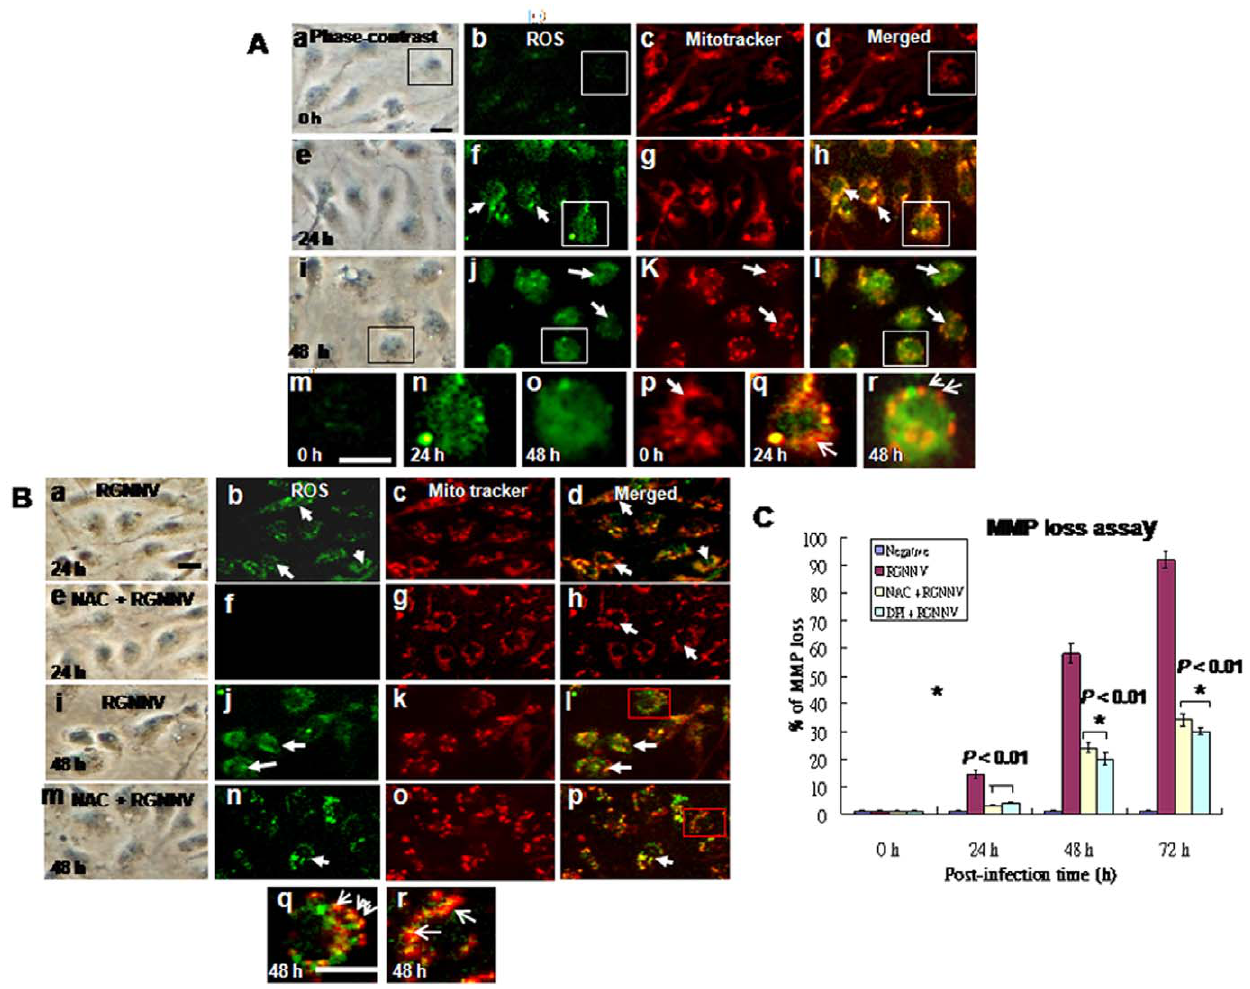
Figure 6. Identification of RGNNV-induced ROS production and the effect of ROS on mitochondrial morphology and loss of DY in GF-1 cells. Phase-contrast and fluorescence micrographs showing ROS production (the Image-iT LIVE Green Reactive Oxygen Species Detection Kit) and mitochondrial morphology (stained by Mito tracker) were in the same cells. (A) RGNNV-infected GF-1 cells at 0 h (a–d), 24 h (e–h; ROS produced in cells, and 48 h (i–l). The elongated mitochondrial network at 0 h in A:d is indicated by arrow in A:p. ROS production at 0 h in A:m is indicated in open square in A:b; at 24 h pi in A:n and p is indicated open square in A:f and h; at 48 h pi in A:o and r is indicated in open square in A:j and l. Breakdown of mitochondrial fission (indicated by arrows) at 48 h pi in A:r is indicated open square in A:l. Scale bar=10 m m. (B) RGNNV-infected GF-1 cells treated with NAC at 24 h (e–h) and 48 h pi (m–p), or not treated at 24 h (a–d) and 48 h pi (i–l) with RGNNV infection. Blockade of mitochondrial breakdown in RGNNV-infected GF-1 cells at 48 h pi in B:p is indicated open square in B:l, which were appeared some dot of mitochondria and indicated by arrow; without RGNNV-infected cells at 48 h pi in B:r is indicated open square in B:p, which have shown more longer mitochondria in length that indicated by arrow. Scale bar=10 m m. (C) The effect of anti-oxidants NAC and DPI on DY in cells infected with RGNNV. The D Y (MMP loss) of RGNNV-infected GF-1 cells treated or not treated with NAC or DPI was determined at 0, 24, 48, and 72 h pi in triplicate. Statistical comparisons were made using either a paired or unpaired Student’s t -test, as appropriate. * P ,